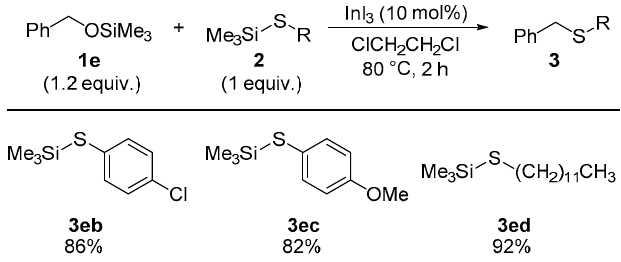
Scheme 2. Substitution reaction using different types of thiosilanes.